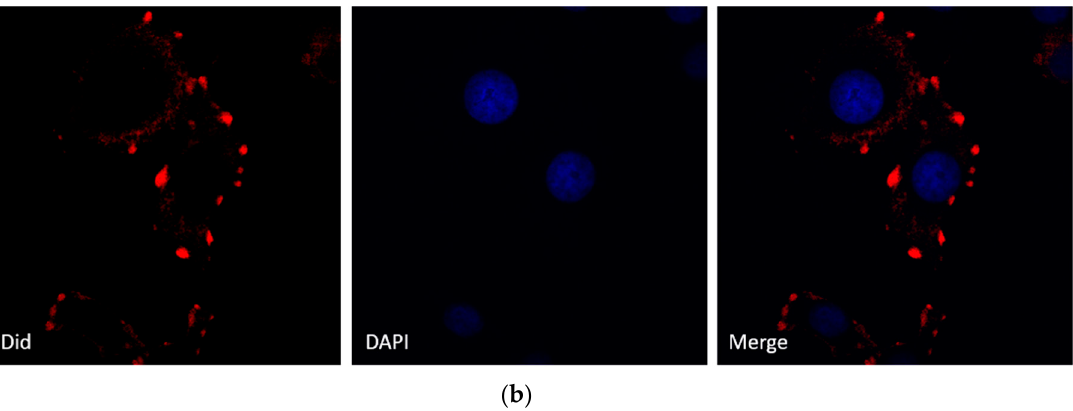
Figure 3. Effects of MCF-7-derived exosomes on proliferation. ( a ) Different concentrations of exosomes from 0–800 µg/mL promote cell proliferation in a dose-dependent manner. The data are collected from three-independent experiments; ( b ) Confocal microscopy visualization of an exosome infused MCF-7 cell line. Secreted exosomes were stained with the cell membrane dye Did. The nuclei were stained with the nuclear dye (DAPI). Merged picture was shown.